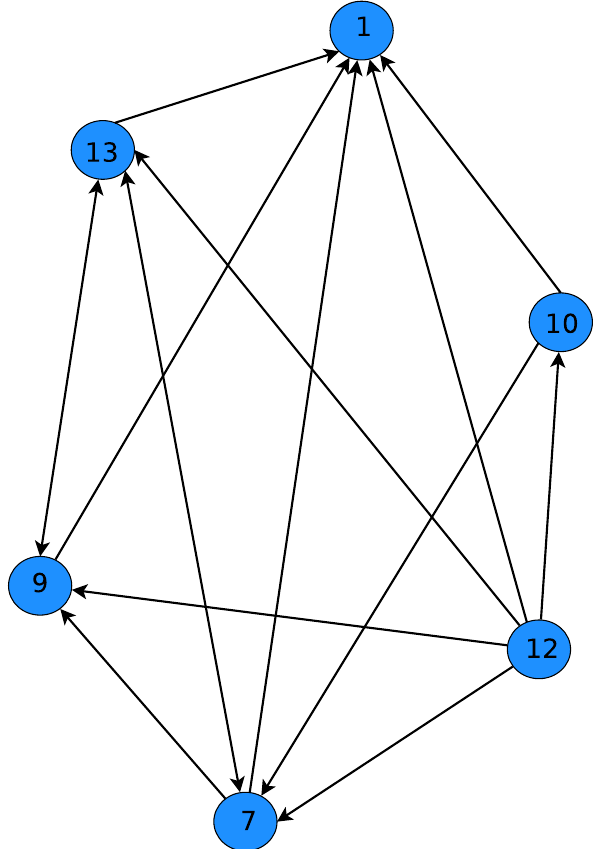
Figure 4. CTP Links originating from Node